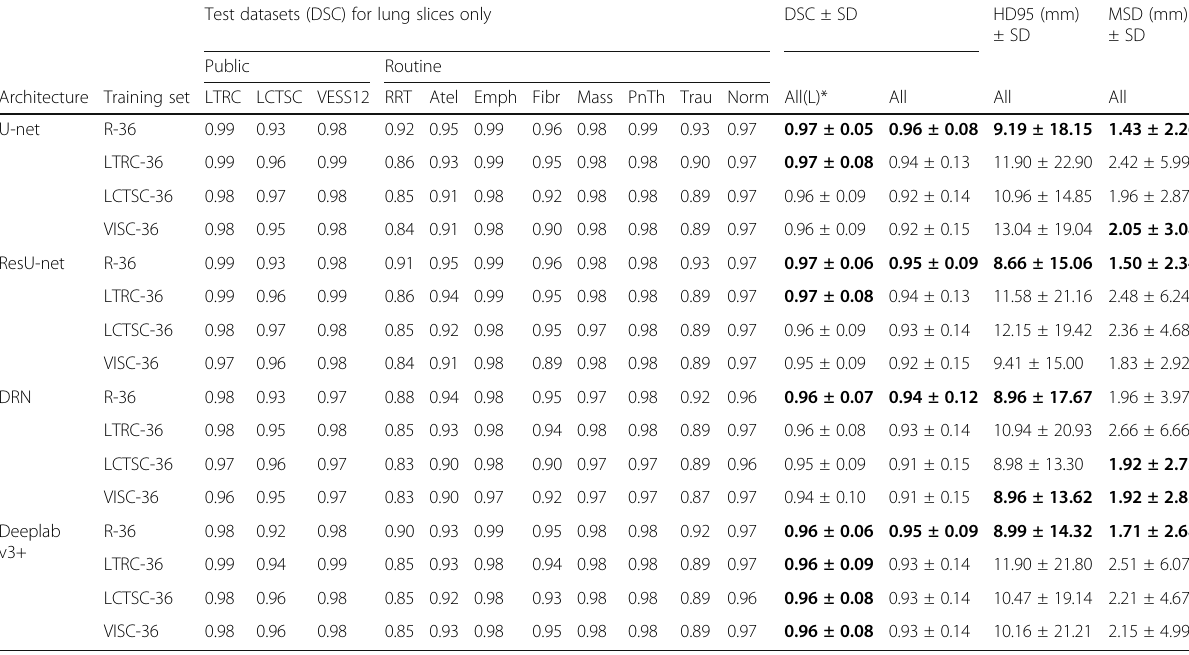
The sets R-36, LTRC-36, LCTSC-36, and LTRC-36 and VISC-36 contained the same number of volumes and slices. The best evaluation scores for models trained on these three datasets are marked in bold, highest for the Dice similarity score (DSC) and lowest for the Robust Hausdorff distance (HD95) and *The LCTSC ground truth masks do not include high-density areas, and the high number of LTRC test cases dominates the averaged results. Thus, “ All(L) ” ( n = 167) is the mean over all cases including LCTSC and LTRC while “ All ” ( n = 62) does not include the LCTSC or the LTRC cases. For abbreviations,